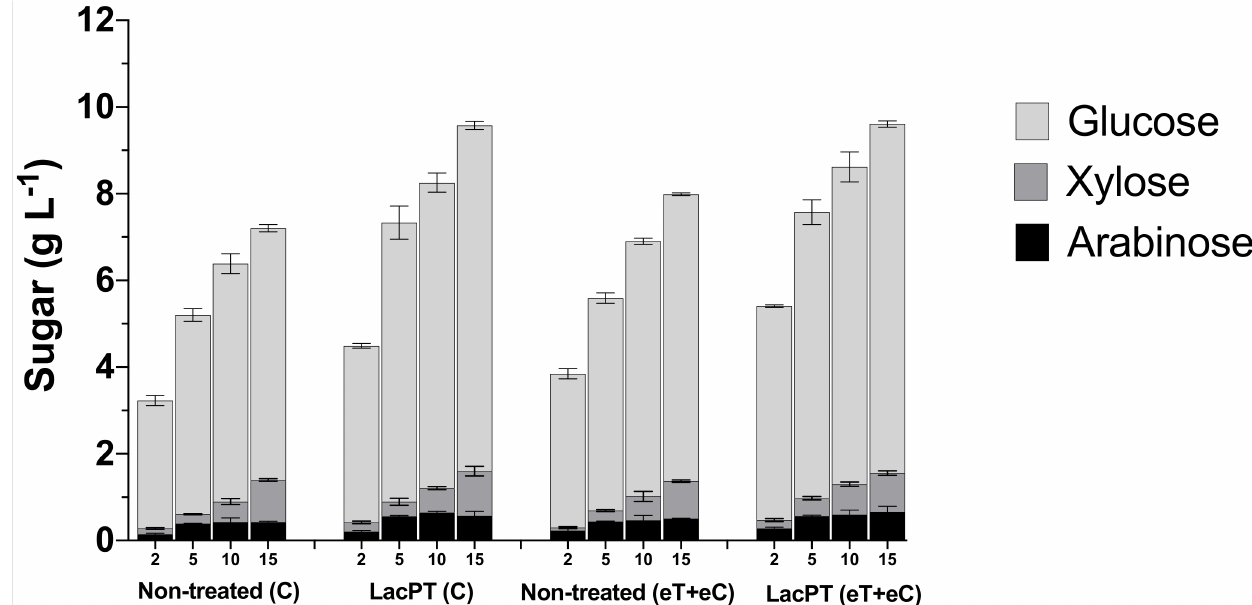
Figure 6. Glucose, xylose, and arabinose yield (g L − 1 ) after enzymatic hydrolysis of non-treated (C and eT+eC) and laccase pretreated (C and eT+eC) biomass at 2, 5, 10, and 15 mg protein/g biomass. Hydrolysis conditions: 5% solid load for 48 h. Treatments: Control (C) and elevated temperature + elevated CO 2 (eT+eC). Mean values ± SD ( n = 3). The p -value was calculated using Tukey’s test and is discussed in the text at the proper place ( p -value, significant <